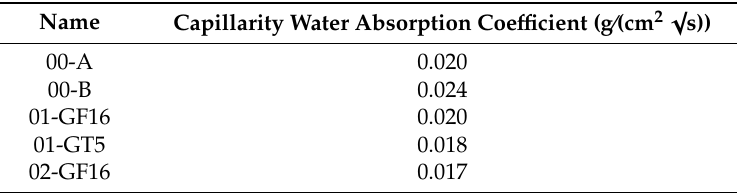
Table 9. Average capillarity water absorption coe ffi